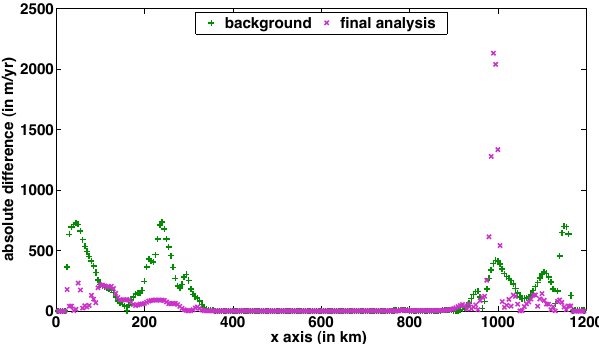
Fig. 12. Absolute difference between final analysis mean (purple x) or background (green crosses) and reference sliding component of surface velocity after 20 years of the 1000-member